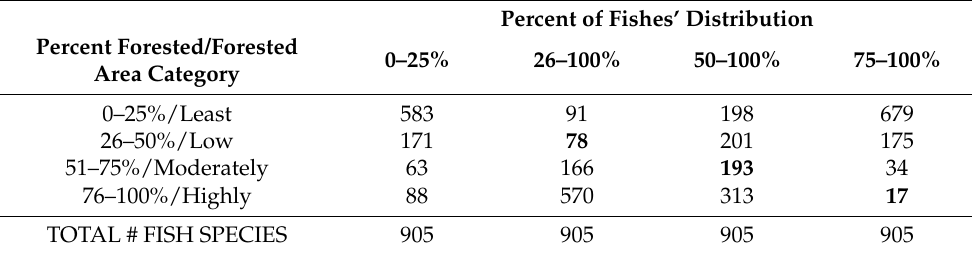
Table 2. Number of native freshwater fish summed across different categories of forested area found in different percentages of fish distribution. The three categories of forest-associated fish highlighted in the rest of the paper are indicated in bold.